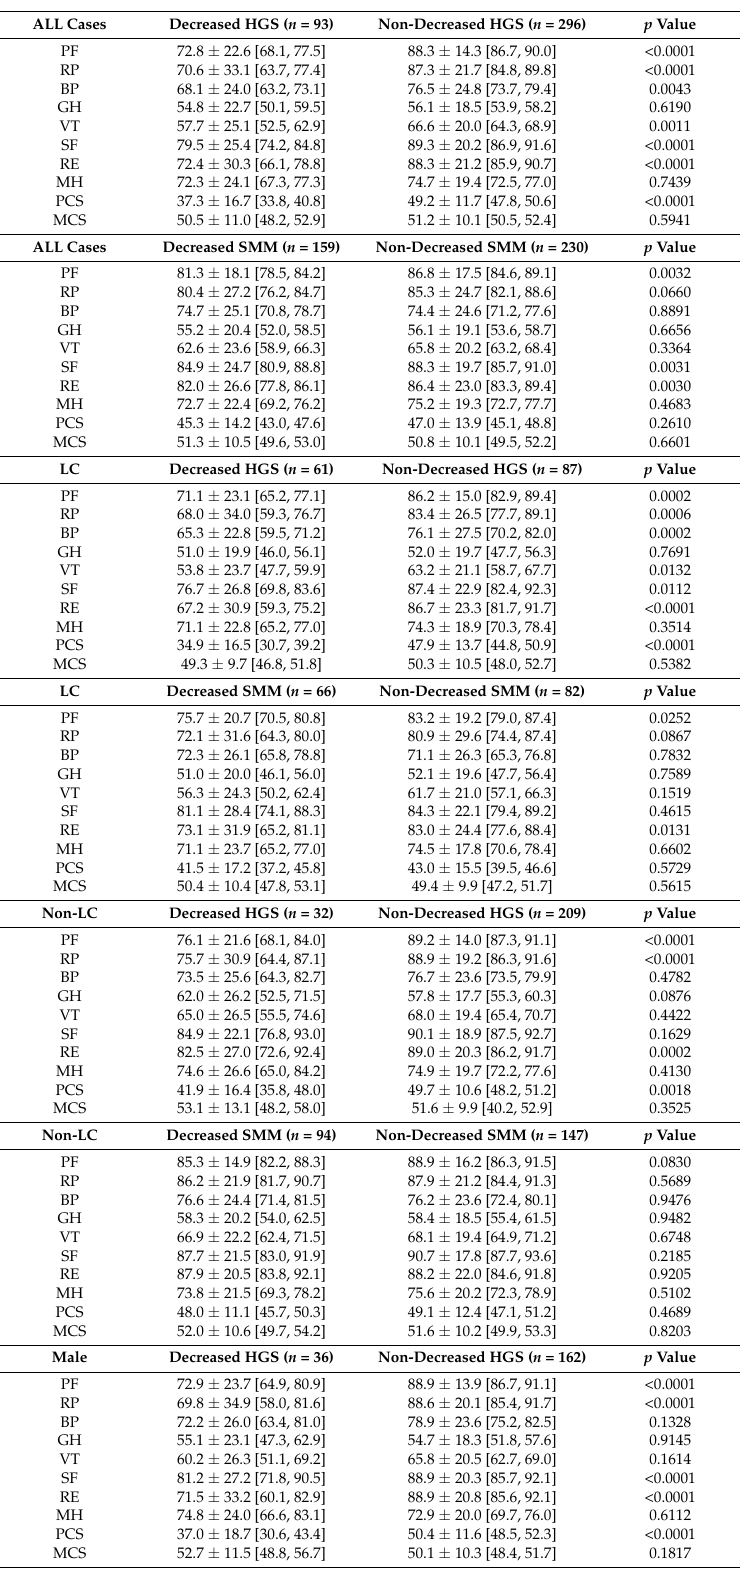
Table 3. Comparison of the SF-36 scores across 10